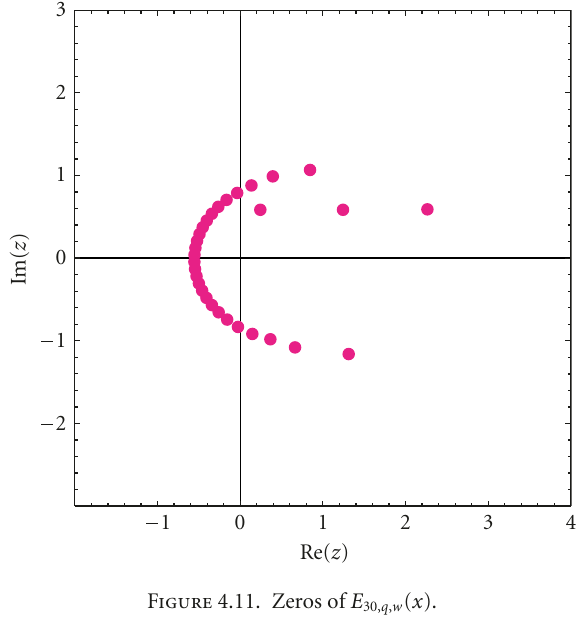
Figure 4.11 . Zeros of E 30, q , w ( x ).